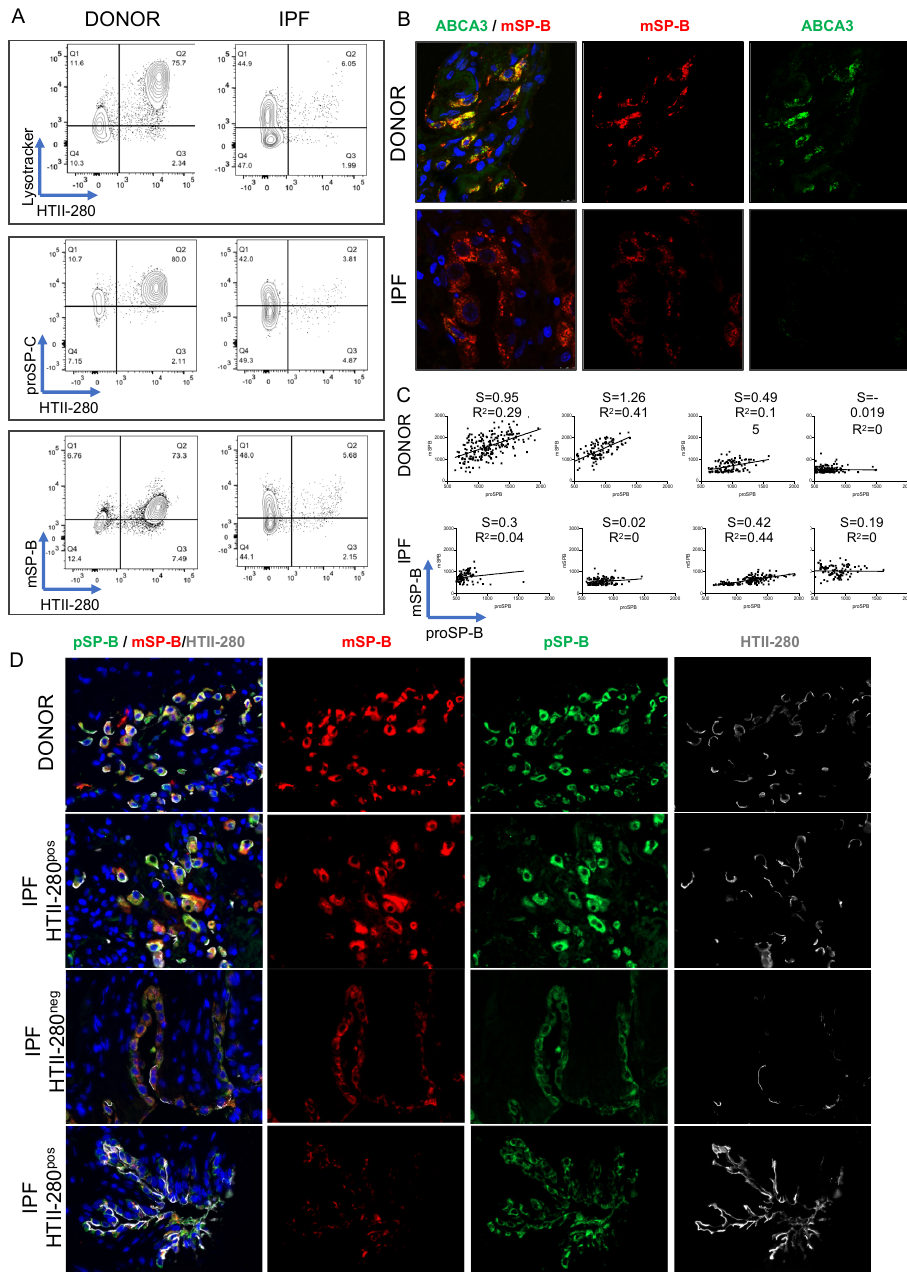
Figure 4. Comparative expression of LysoTracker, proSP-C and mSP-B expression in donor and IPF lung. ( A ) Six donor and six IPF lung preparations were co-stained in parallel with HTII-280, LysoTracker, proSP-C and mSP-B. Representative flow cytometry panels of LysoTracker (upper), proSP-C (middle) and mSP-B (lower) vs. HTII-280 expression in the epithelial compartment of one donor (left column) and one IPF (right column) lung. ( B ) Representative immunofluorescence images of mature (red) and ABCA3 (green) in donor and IPF paraffin-embedded lung tissues. ( C ) Quantification of the fluorescence intensity of the mature SP-B and proSP-B immunofluorescence signals in four donor (upper row) and four IPF (lower row) patients, showing the slope (s) of the linear regression and the correlation index (R 2 ) for each patient. ( D ) Representative immunofluorescence images of the mature (red) and proSP-B (green) in donor and IPF tissues shown in ( C